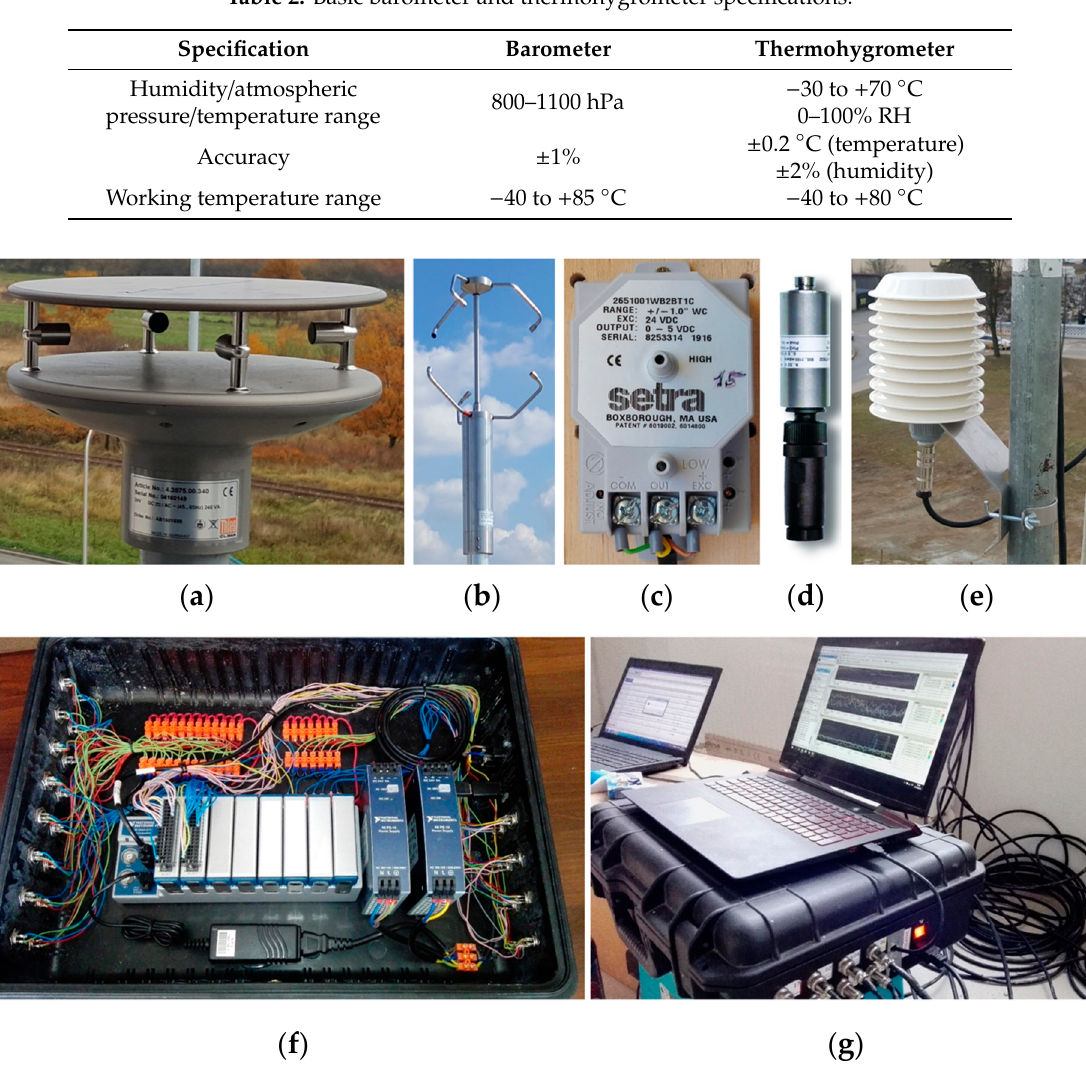
Figure 2. System components: ( a ) 2D anemometer; ( b ) 3D anemometer; ( c ) pressure sensor; ( d ) barometer; ( e ) thermohygrometer; ( f , g ) central unit.